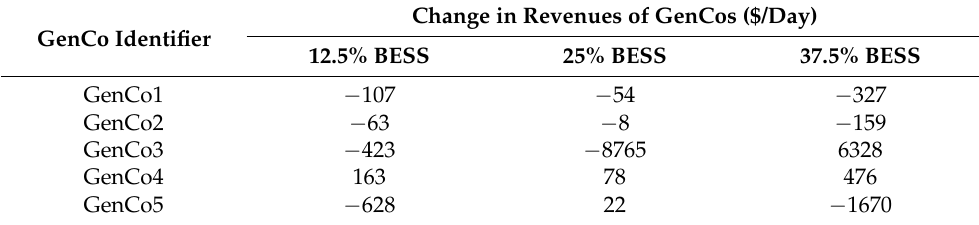
Table 5. Change in Revenue of GenCos as compared to Base Case.